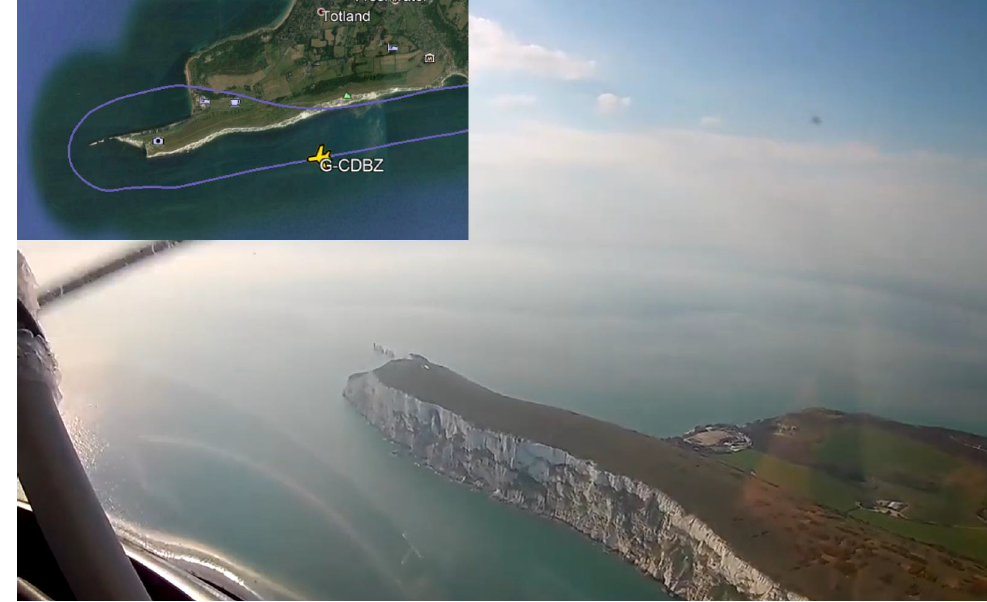
Figure 19. A photograph taken from G-CDBZ during the second flight test with the aircraft tracking displayed on Google Earth imposed on the top left.